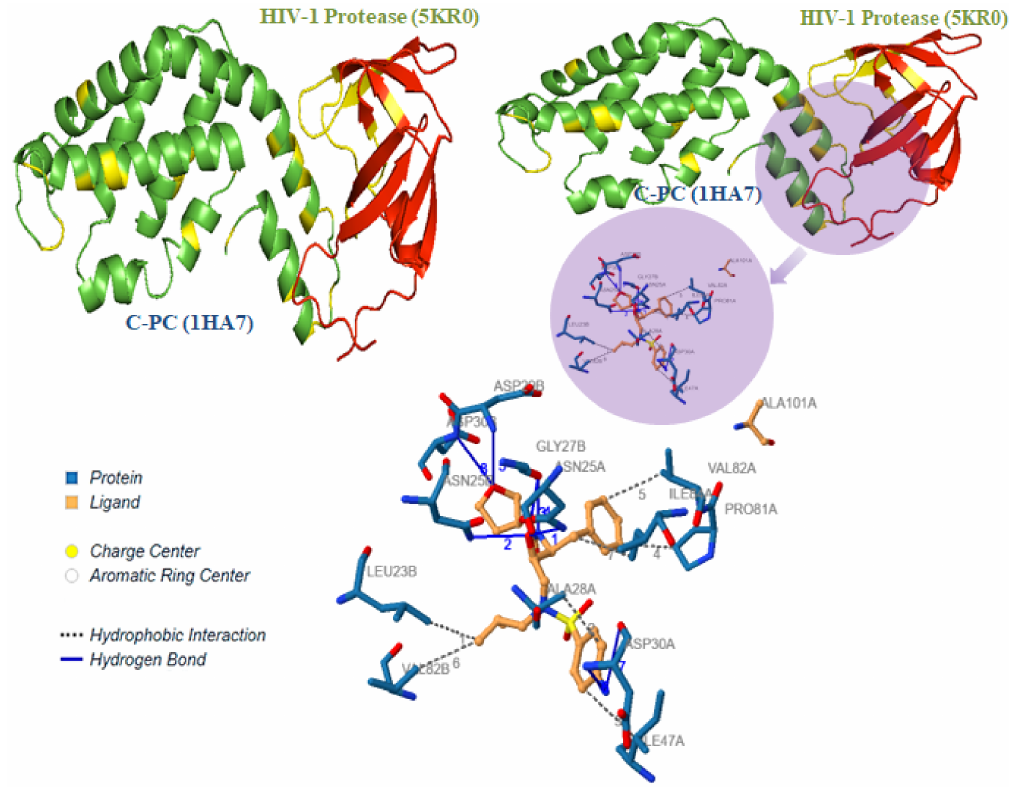
Figure 5. Molecular interactions between C-PC (1HA7) with HIV-1 Protease (5KR0). In silico molecular interactions between C-PC (green) and HIV-1-PR (red) are identified using protein–protein docking and simulations. Notably, active site and sub-site residues responsible for the proteolytic mechanism of HIV-1 PR are occupied by C-PC and hence, reduced HIV-1PR